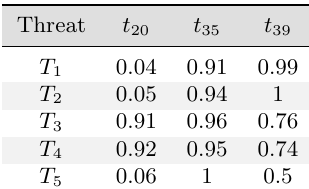
Table 3: Normalised threat values associated with threats T t 39